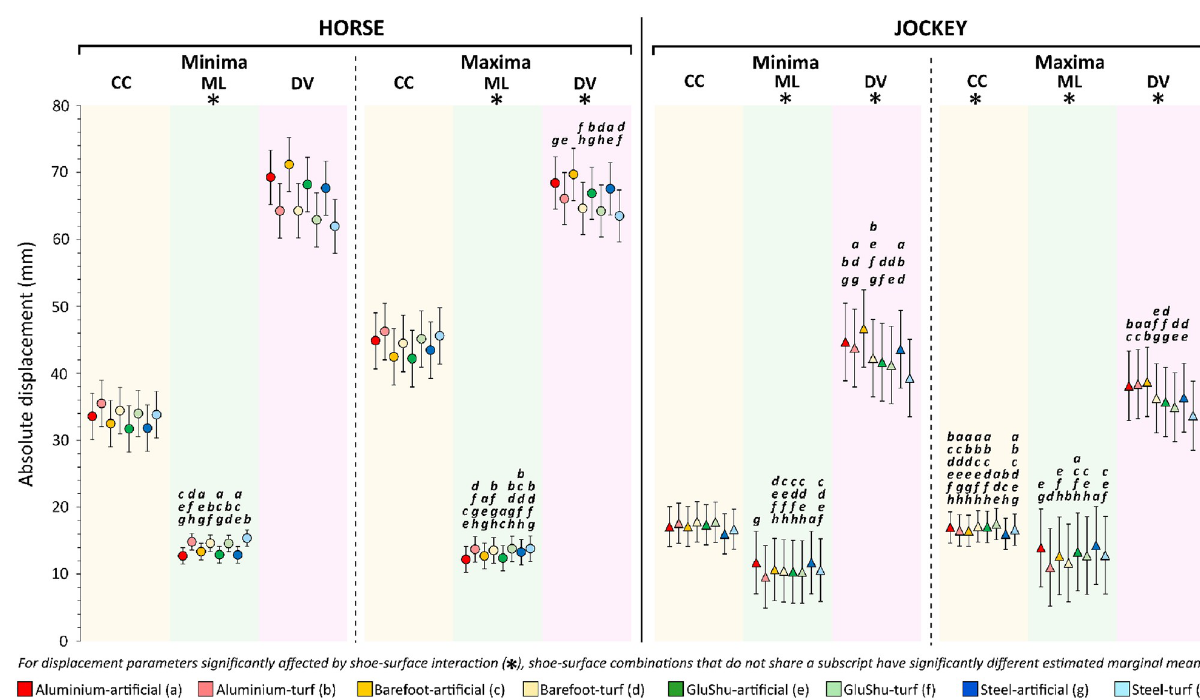
Fig 11. Output of linear mixed models for surface-shoe combinations. EMMs with 95% confidence intervals are presented per shoe-surface combination for each displacement parameter. Significant differences detected in post-hoc tests (with Bonferroni correction) are indicated. Note that pairwise comparisons between shoe-surface combinations in a particular axis direction were only made when there was found to be a significant interaction between shoeing condition and surface. CC = cranio-caudal, ML = medio-lateral, DV = dorso-ventral.